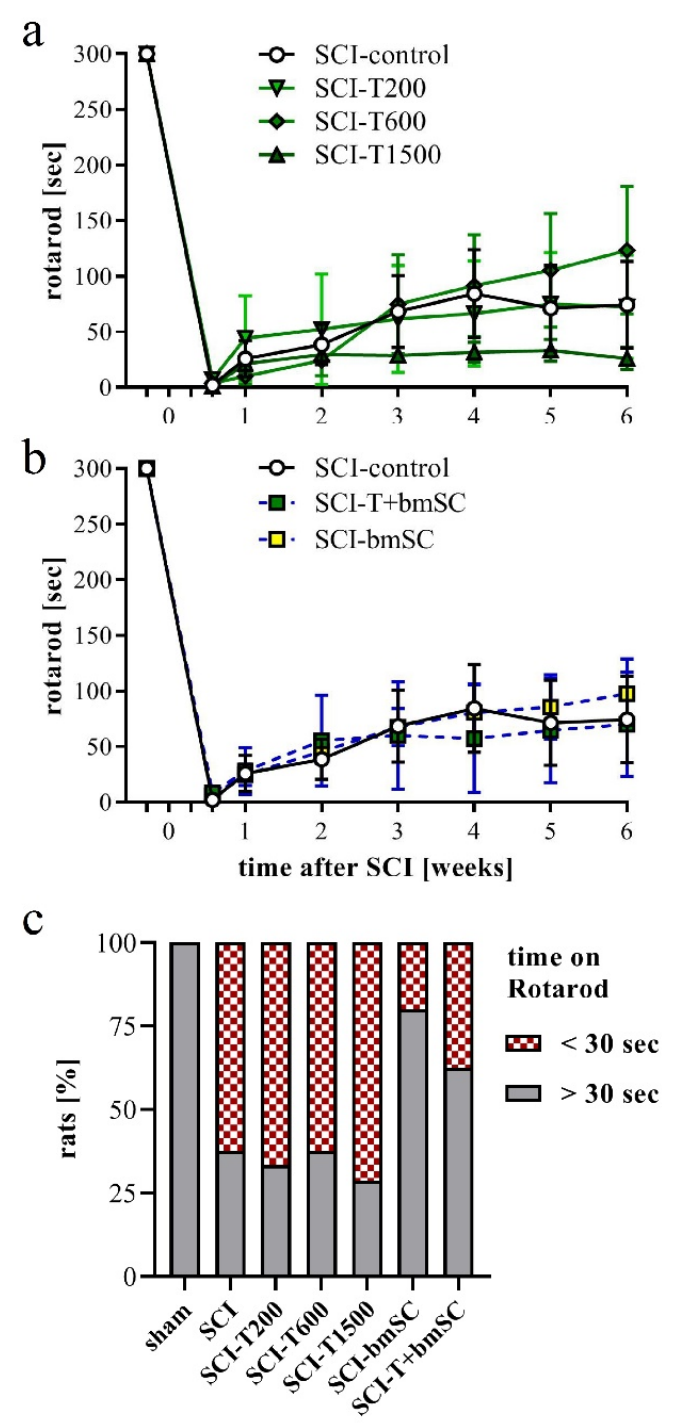
Figure 4. Recovery of motor functions after SCI assessed with the Rotarod assay. At 4 dpo, we confirmed that no SCI treated animals showed weight supported steps. Beginning at 7 dpo, some rats in all groups showed gradual improvement. ( a , b ) Time that rats were able to keep their balance on the rotating bar; mean +/ − SEM, no significant differences between groups were detected. ( c ) Percentage of rats that performed the Rotarod task for more than 30 s at 6 W after SCI (n = 7–8 rats/group). Experimental groups are indicated as in Figure